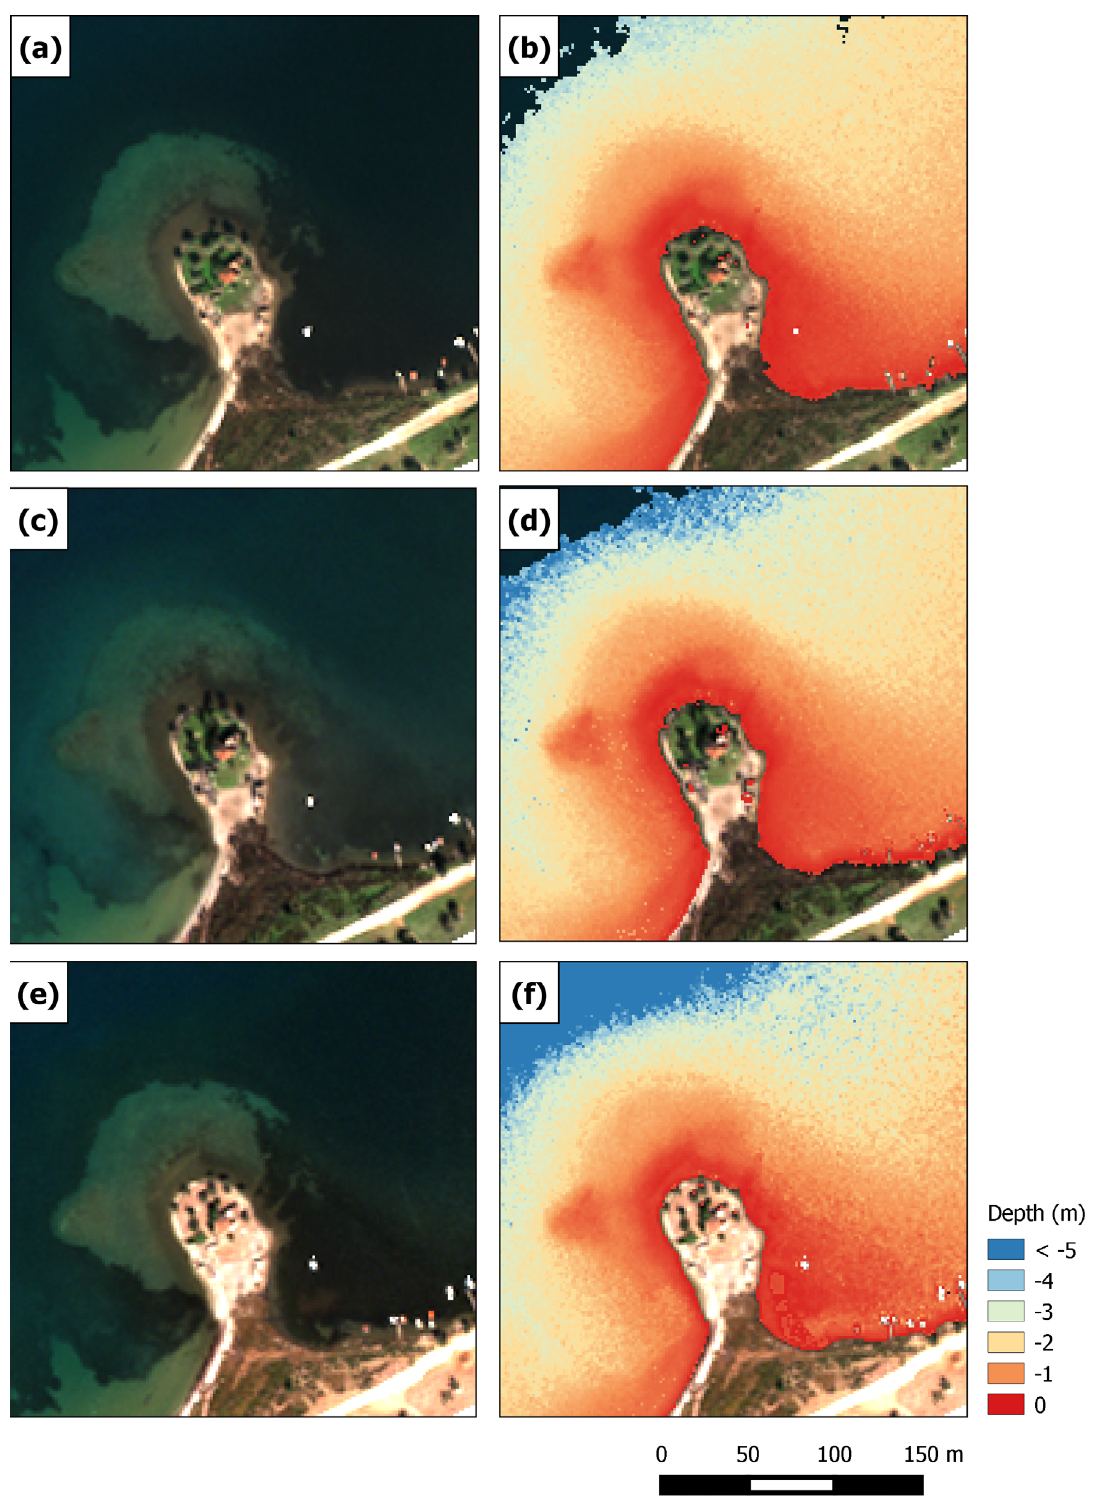
Figure 5: True color composite WorldView2 images (left column) and HOPE derived bathymetry maps (right column) of the area surrounding the Metohi peninsula. (a) and (b) – image taken on 26.10.2010; (c) and (d) – image taken on 31.01.2013: (e) and (f) – image taken on